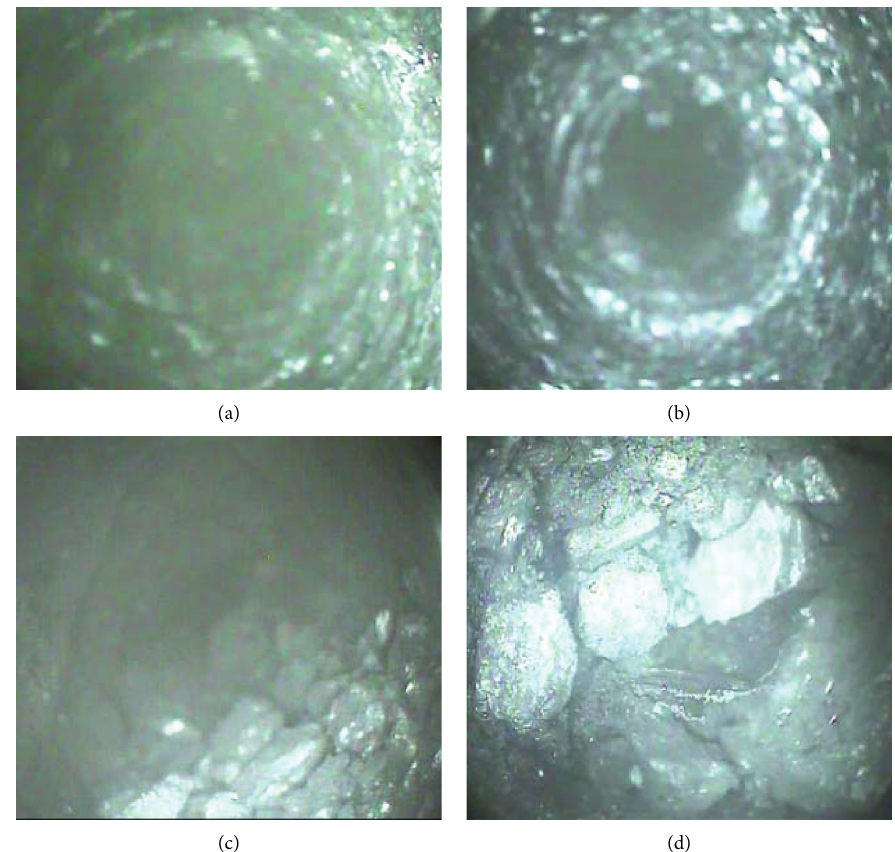
Figure 16: External test in 10# borehole: (a) drilled after 48h, (b) drilled after 168h, (c) drilled after 240h, and (d) drilled after